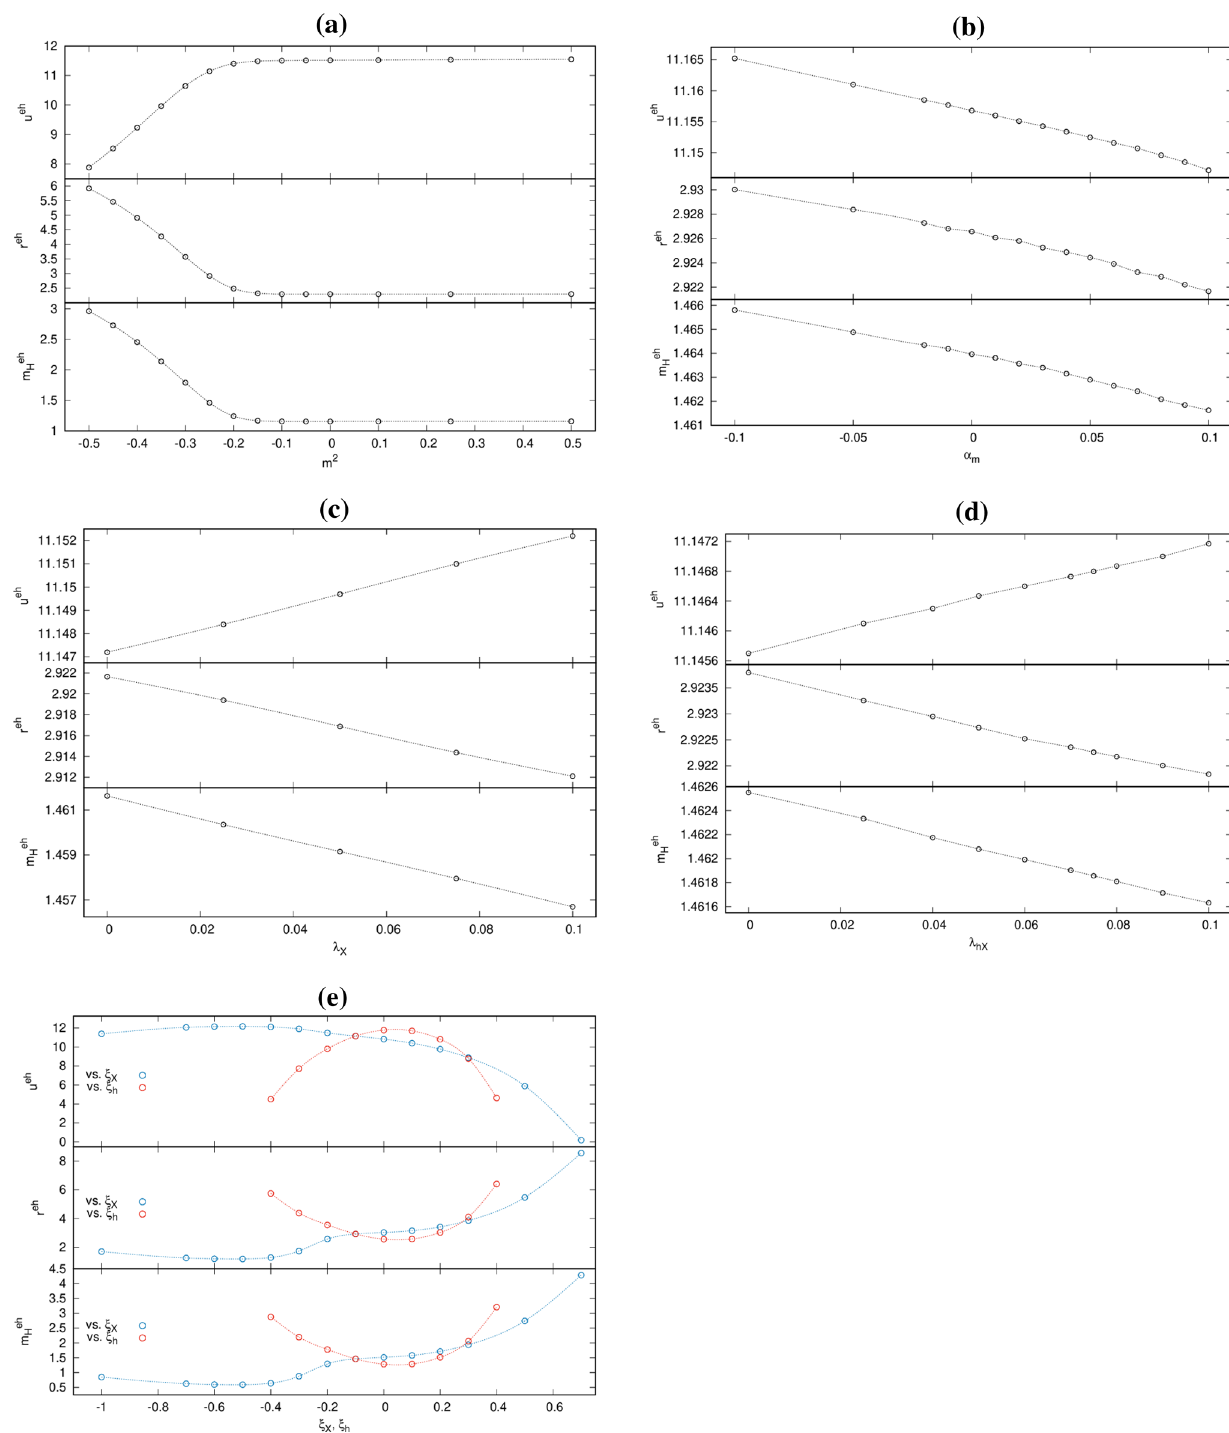
Fig. 11 The u -locations of the event horizons, u eh , radii, r eh , and masses, m eh , of black holes formed during the gravitational col- H lapse with non-minimal scalar–gravity couplings as functions of a m 2 ,